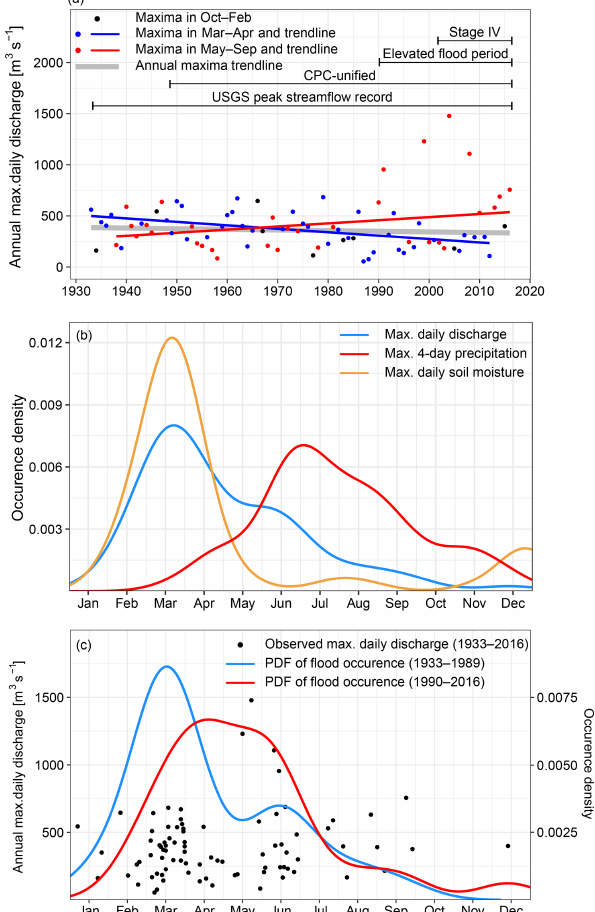
Figure 3. (a) Linear trends for two groups of annual maximum daily discharge: March–April floods (blue) and May–September floods (red) using the nonparametric Thiel–Sen estimator (Sen, 1968). The October–February maximum daily discharges are in black dots and their trend line is not calculated because only nine annual maxima occur during this period. The four critical time ranges are shown in black lines. (b) Occurrence densities of the date during the year for the observed annual daily maximum discharge, observed annual 4d maximum precipitation, and simulated annual daily maximum soil moisture in the Turkey River watershed from 1948 to 2016. (c) The magnitude and date during the year for annual flood peaks (black dots) and sample probability density functions (PDFs) for floods in different periods (1933–1989, 1990–2016). In this study, all probability densities for the occurrence date are estimated using Gaussian kernel